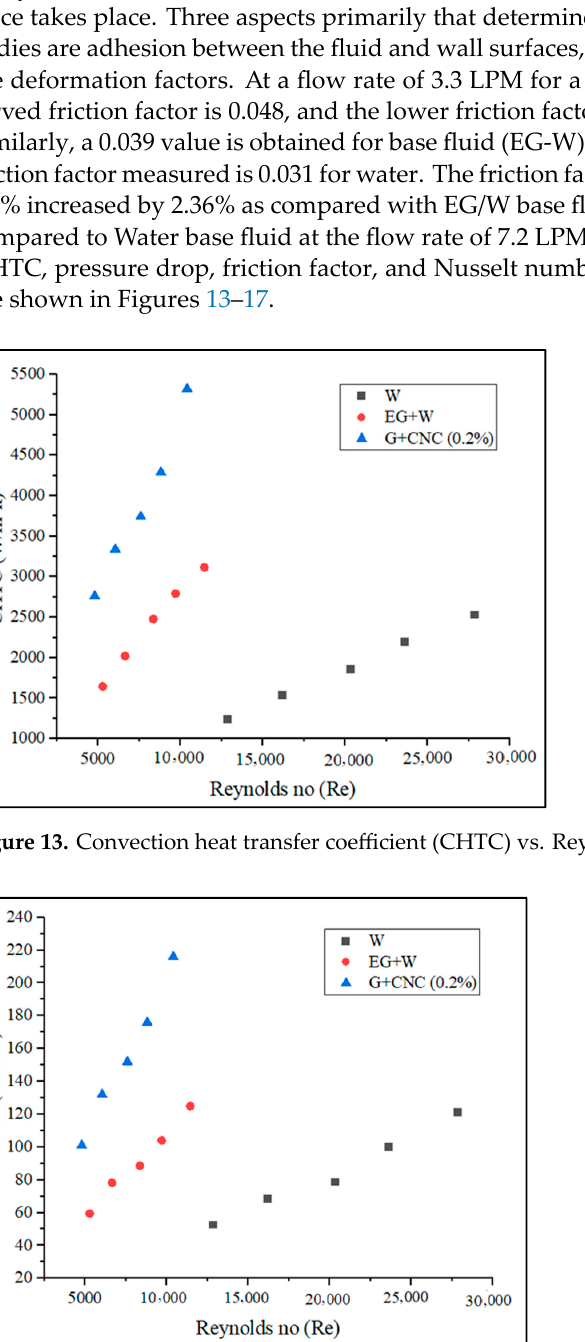
Figure 15. Pressure drop (kPa) vs. Reynolds number (Re).